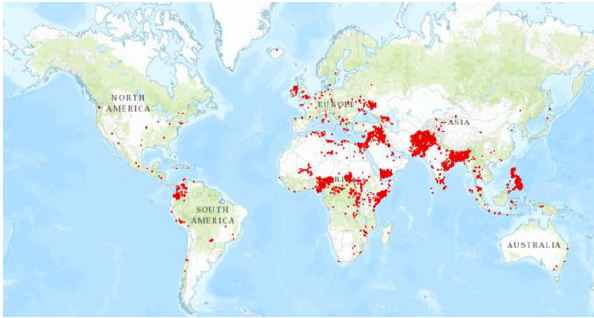
Table 3 Event data table structure